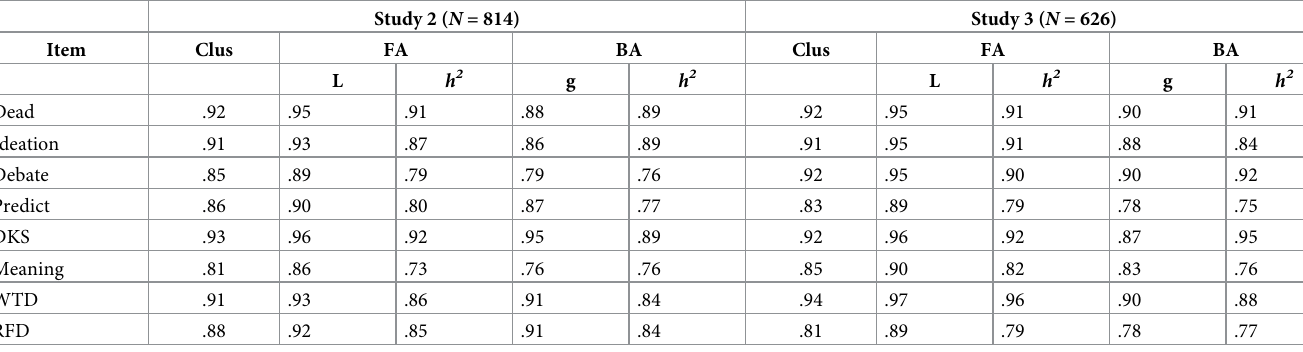
Table 6. Suicidality Scale cluster, factor analysis and bifactor analysis, studies 2 and 3.